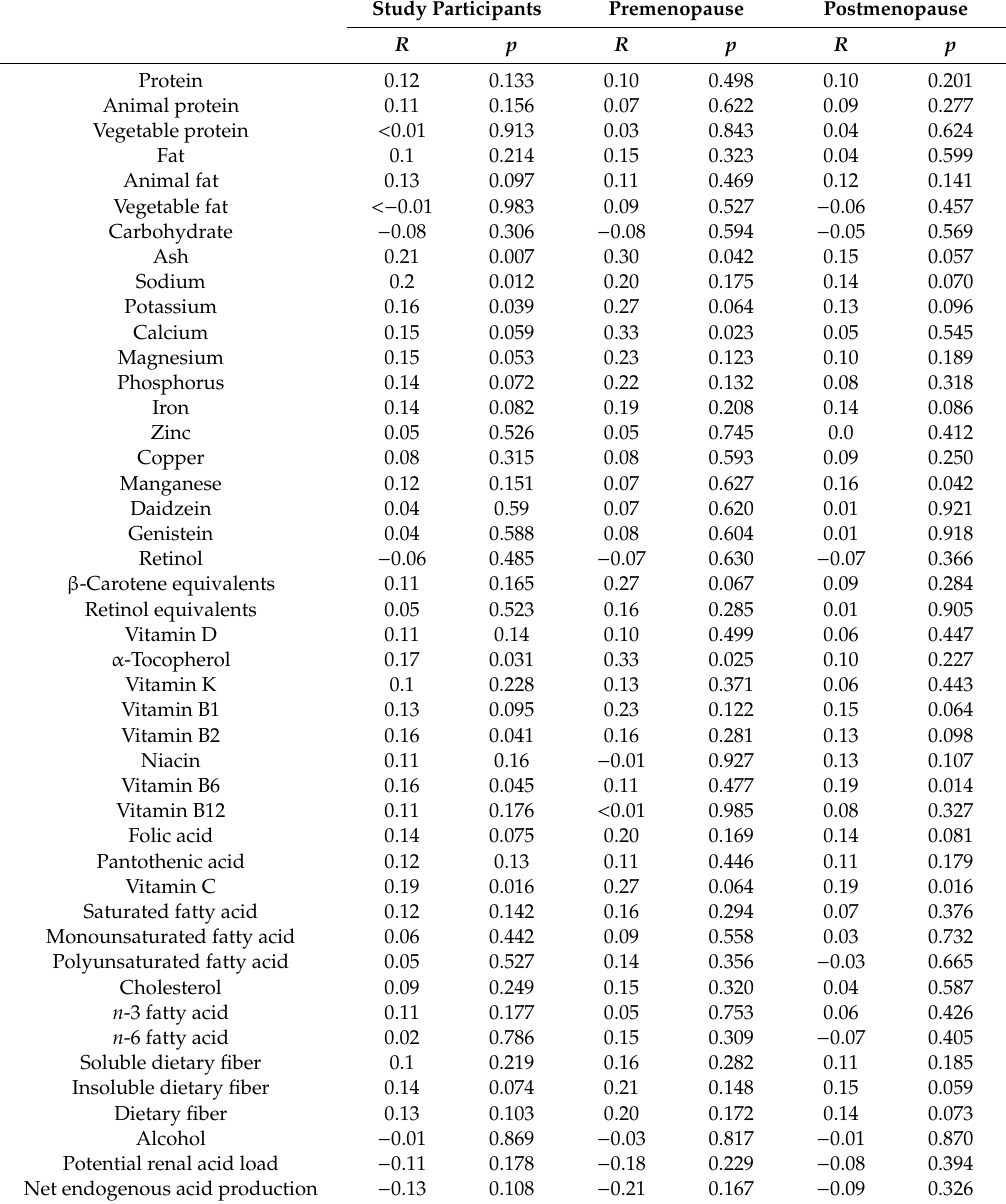
Table 3. Correlations between 43 nutrient factors and dietary acid load and the bone mineral density (BMD) Z-score in the study